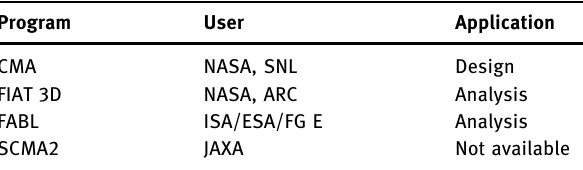
Table 2: Simulation programs for ablation